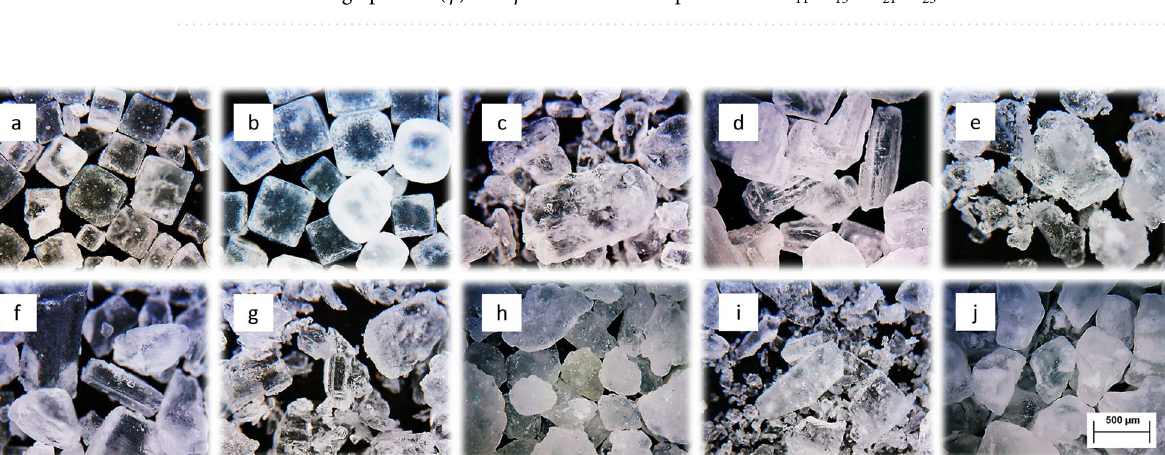
Table 2. Summing up of tan ( φ ) and φ of individual displacements T 11 –T 15 a T 21 –T 25 .